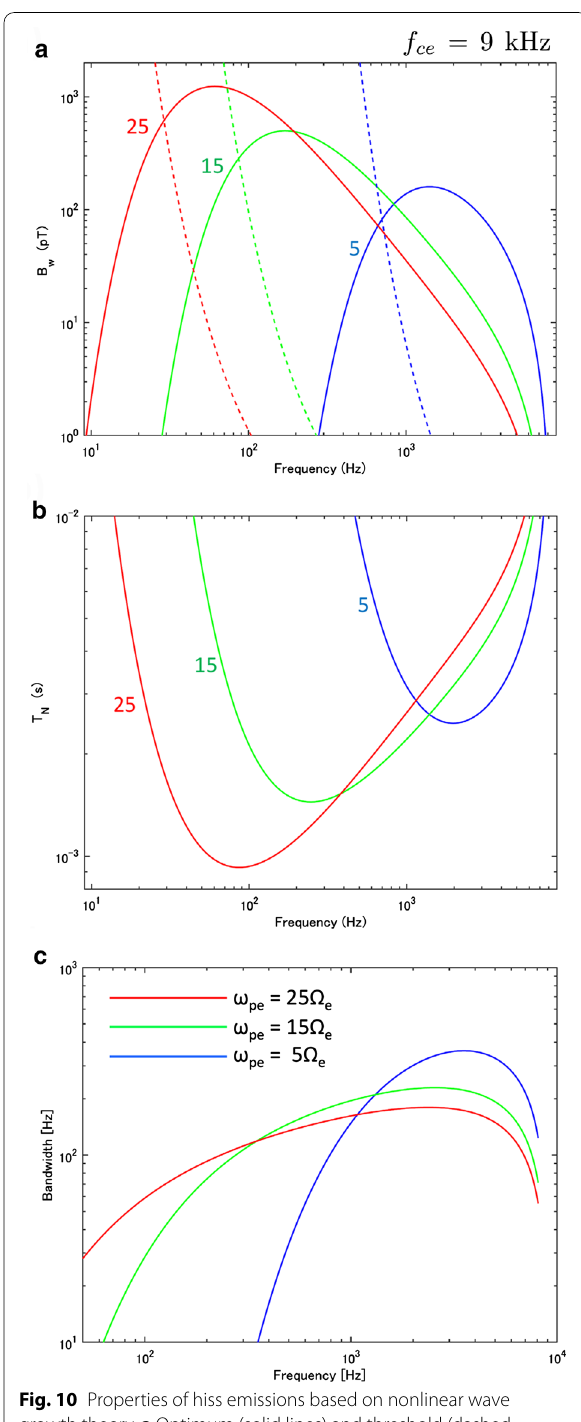
Fig. 10 Properties of hiss emissions based on nonlinear wave growth theory. a Optimum (solid lines) and threshold (dashed lines) amplitudes, b nonlinear transition time T N with τ c bandwidth as coherent waves for different cold plasma densities specified by the electron plasma frequency f pe normalized by the 9 kH cyclotron frequency f ce =